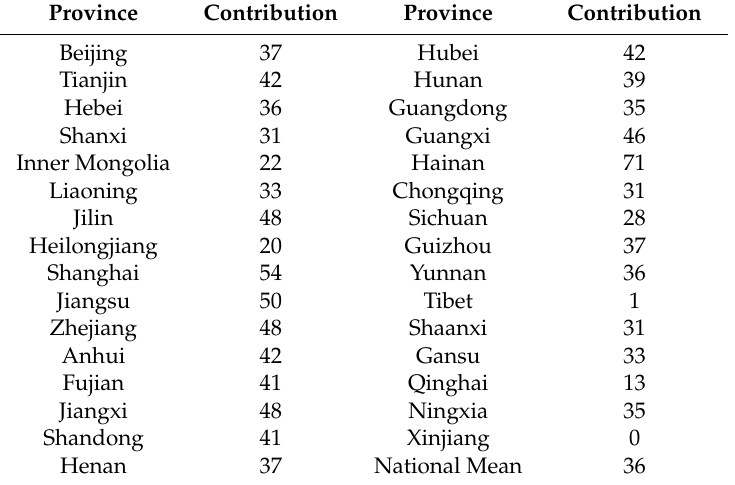
Table 2. Contribution of outside sources to PM 2.5 (diameter of fine particulate matter less than 2.5 µ m) (%).